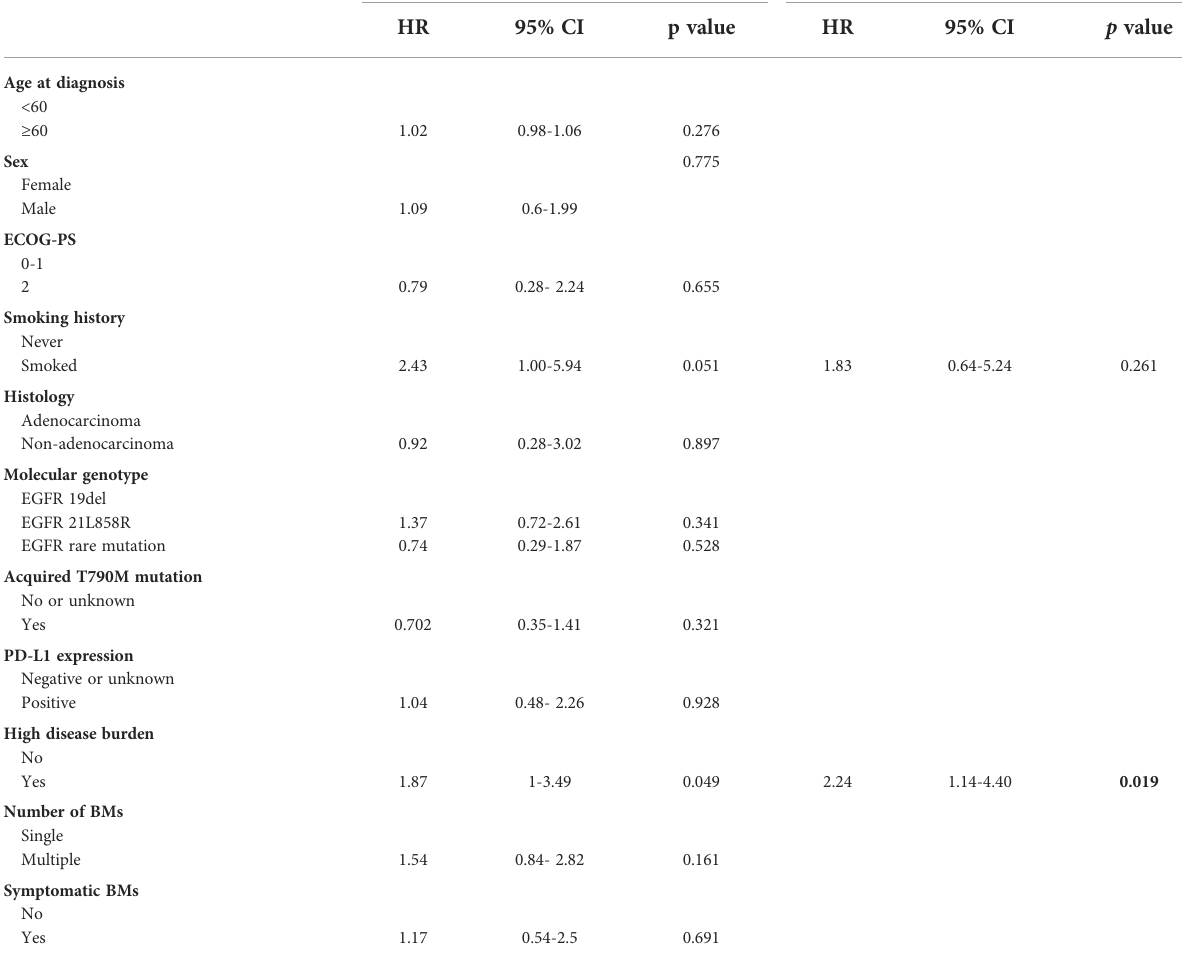
TABLE 4 Univariate and multivariate survival analyses of overall